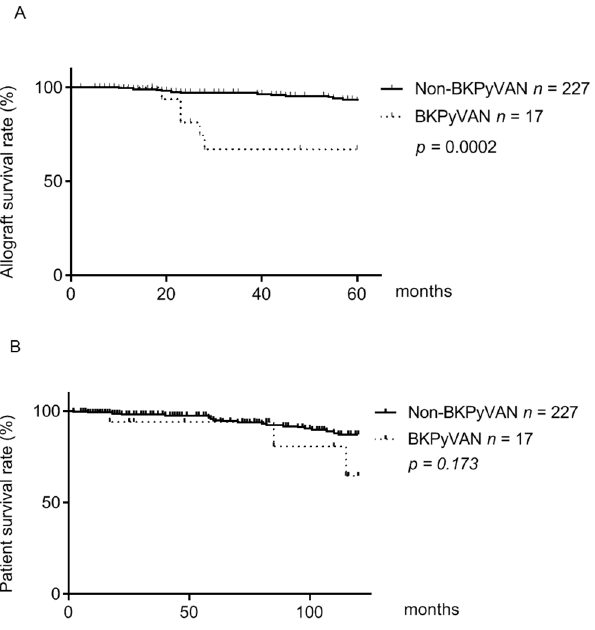
Figure 1. Kaplan–Meier analysis of allograft survival and patient survival in patients with and without BKPyVAN. Patients were classified into the BKPyVAN and non-BKPyVAN groups. The allograft survival ( A ) and patient survival ( B ) were assessed by Kaplan–Meier analysis.